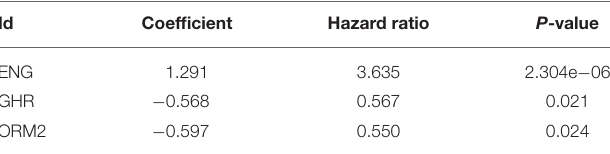
TABLE 2 | Three-gene identified using Cox regression analysis and the LASSO regression